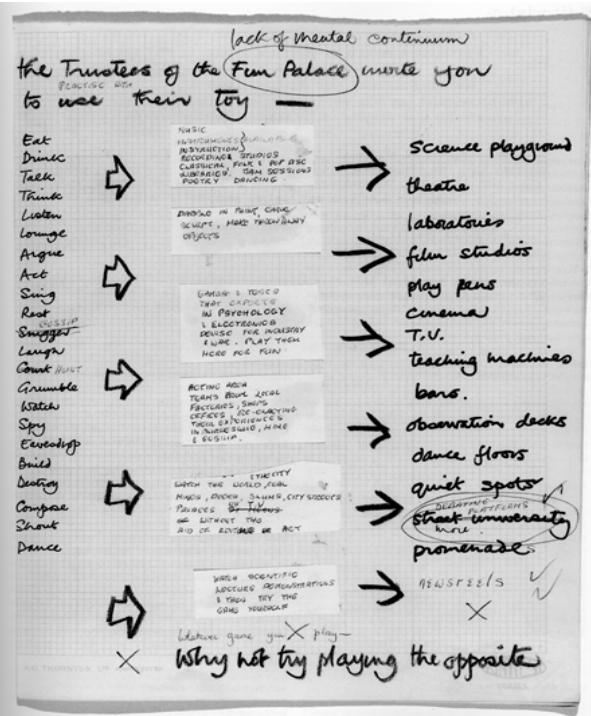
FIG. Cedric Price, Fun Palace, Perspective sketch and drawing, 1964